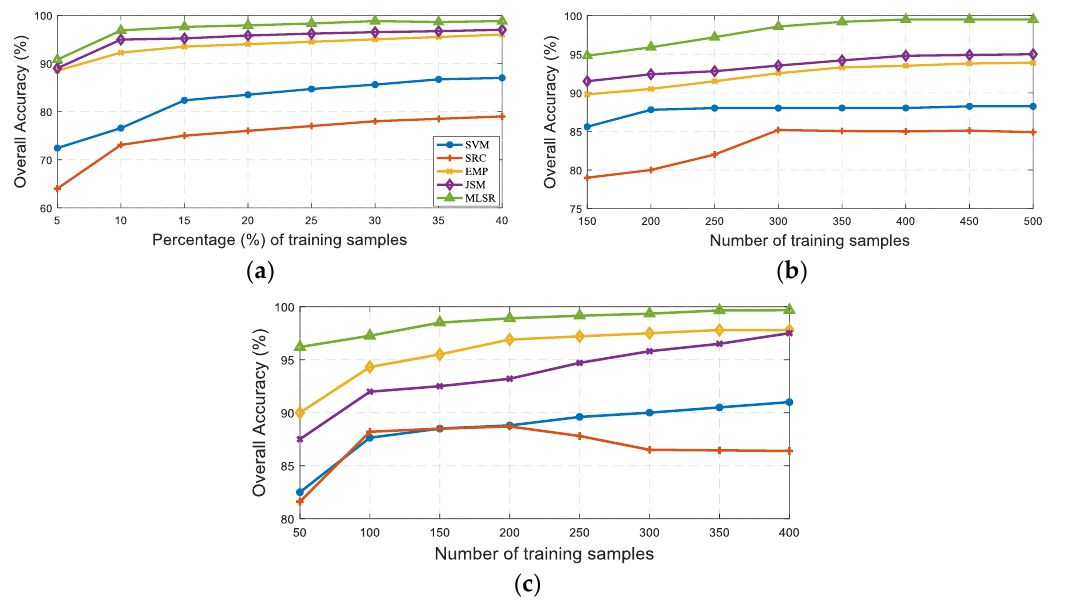
Figure 9. The effect of numbers of training data on five different methods: ( a ) Indian Pines; ( b ) University of Pavia; and ( c ) the Salinas scene.